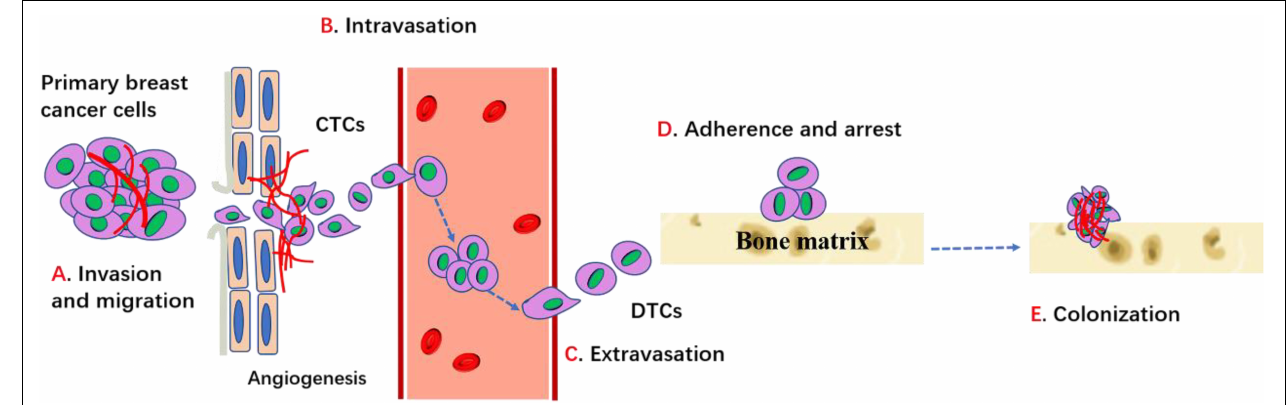
FIGURE 1 | Process of breast cancer bone metastasis. Cancer cells proliferate, invade into surrounding tissues and escape from primary site through the regulation of cadherins, MMPs, integrins and other factors. Then cancer cells enter into the circulation (intravasation) and migrate toward bone through the conduct of chemokines and other factors, etc. When cancer cells egress blood vessels (extravasation) and arrive bone target, it can adhere and bind with bone matrix and get arrest through integrins and cadherin. Then cancer cells can survive, proliferate and differentiate through the interaction with bone microenvironment which ultimately lead to the establishment of bone